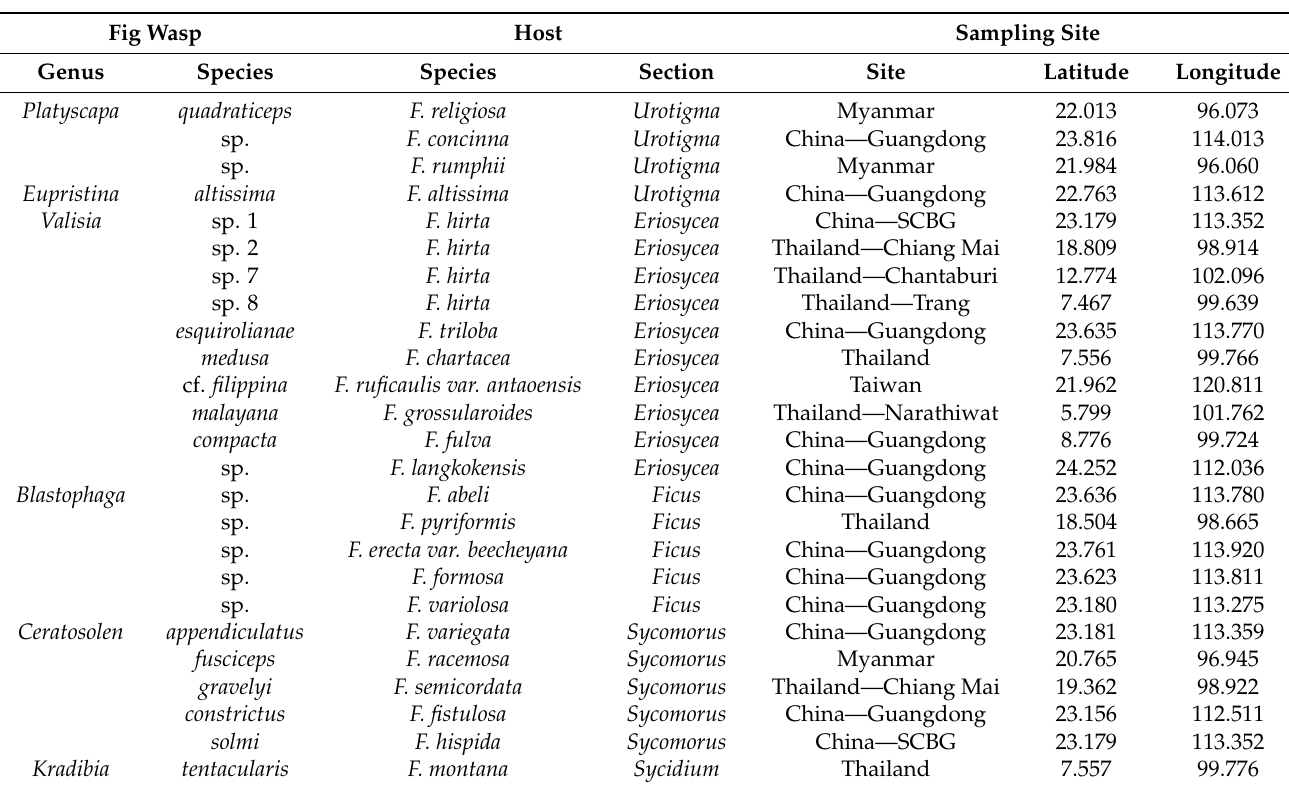
Table 1. Information on fig wasps used for transcriptome sequencing. Valisia sp. 1, sp. 2, sp. 7, and sp. 8 are the different pollinating species with allopatric distribution within a single host, F. hirta [9]. It has been reported that the pollinating wasps in F. pyriformis , F. erecta var. beecheyana , F. formosa , F. variolosa , and F. abeli are the same species according to the morphology and DNA sequences [35–39]. Our results also confirmed that they form a single clade. We considered them as one species with five hosts: B. sp.- F. abeli , B. sp.- F. pyriformis , B. sp.- F. formosa , B. sp.- F. erecta var. beecheyana , and B. sp.- F. variolosa